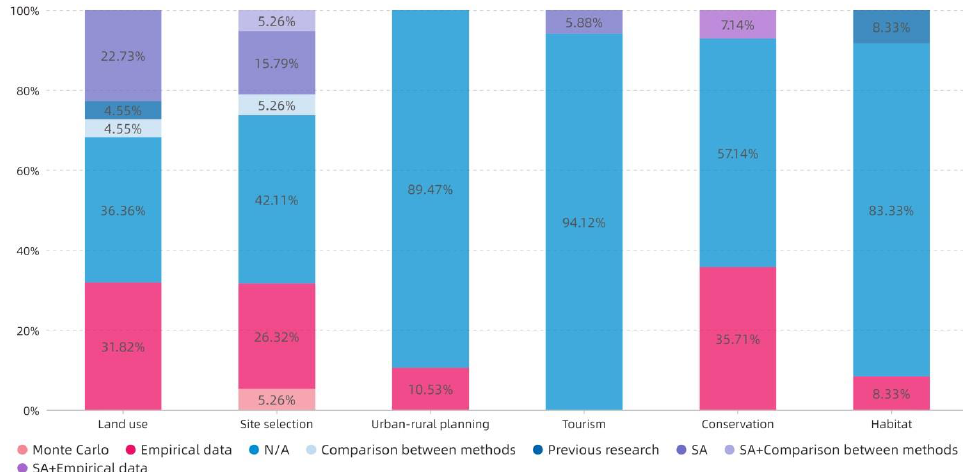
Figure 17. The topic distribution of the proportion of verification